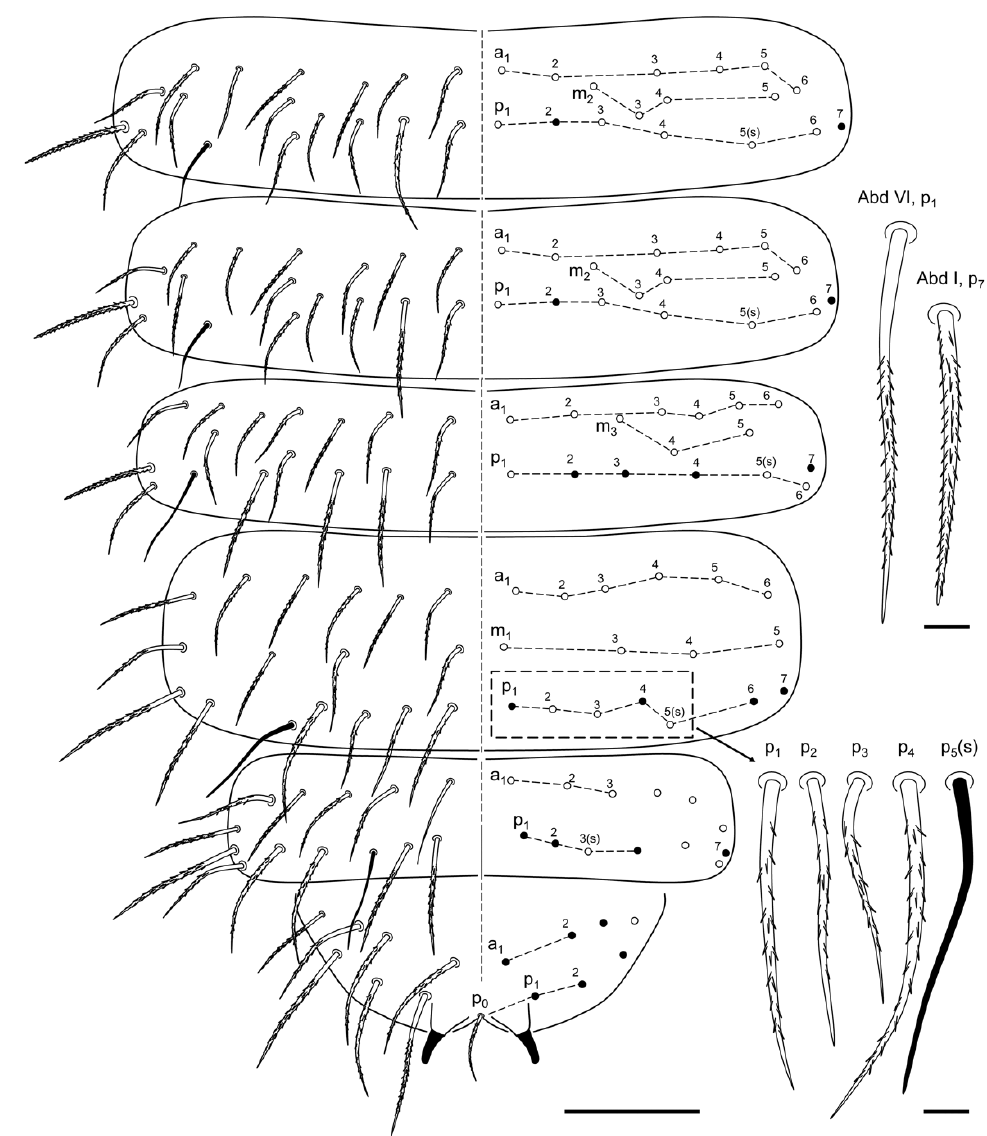
Figure 6. Ceratophysella meridionalis : Abd I–VI, with detail on some of the chaetae (scale bars: abdominal tergites, 0.1 mm; chaetae, 0.02 mm).